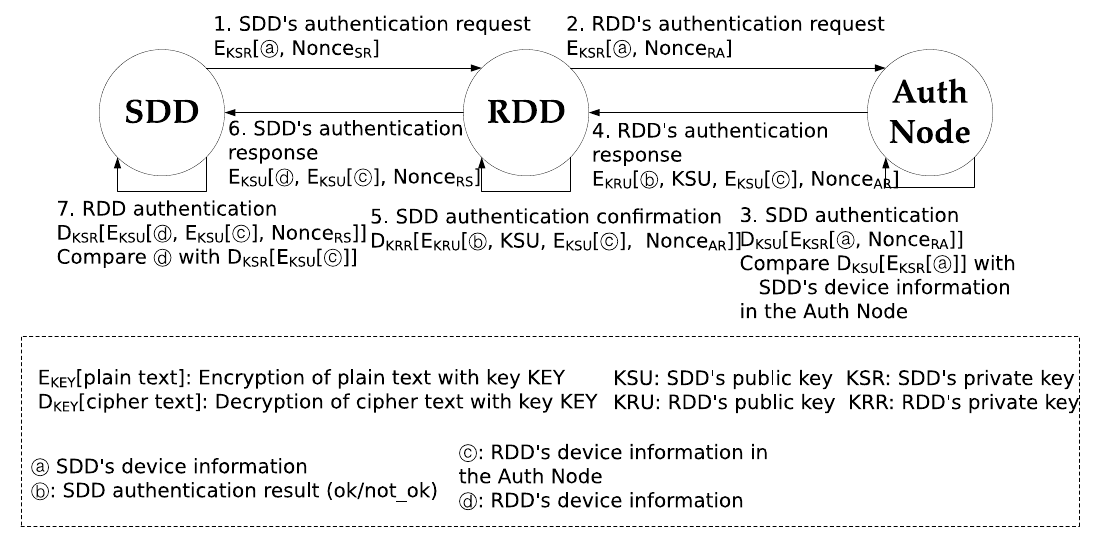
Figure 5. SDD/RDD authentication process . Figure 5. SDD / RDD authentication